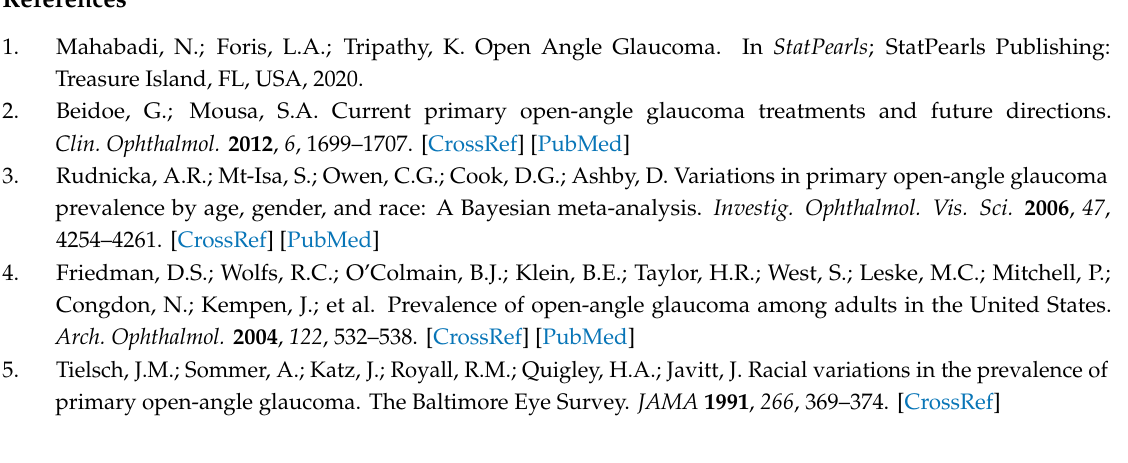
Figure S1: Schematic representation showing CDKN2B-AS1 , CDKN2B and CDKN2A gene and location of rs4977756 (indicated by arrowhead) within CDKN2B-AS1 gene; Figure S2: Western blot showing the induction of Myocilin in TM cultures (P2 to P4 cultures) with 100 mM Dexamethasone treatment for 3 days; Table S1: Primers sequence used for real-time RT-PCR analysis of CDKN2B-AS1 , CDKN2B , CDKN2A and p14ARF genes in human retina and HEK293T and TM cells. F = Forward primer, R = Reverse primer; Table S2: Comprehensive list SNPs associated with POAG in 9p21 locus in diverse